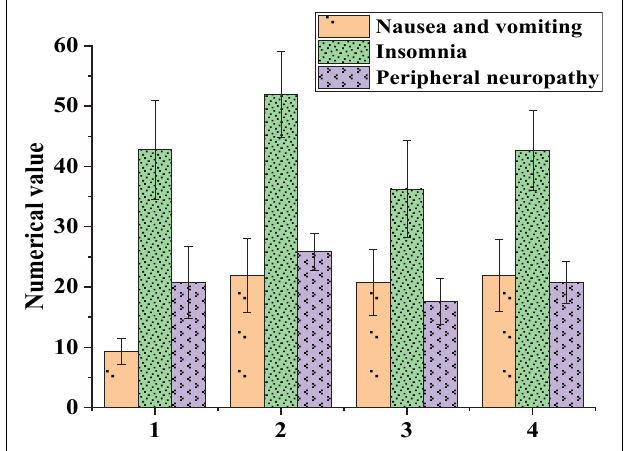
FIGURE 1 | Influences of patients’ clinical characteristics on their quality of life (1: Stage I-II; 2: Stage III-IV; 3: Chemotherapy less than 3 times; 4: Chemotherapy more than 3